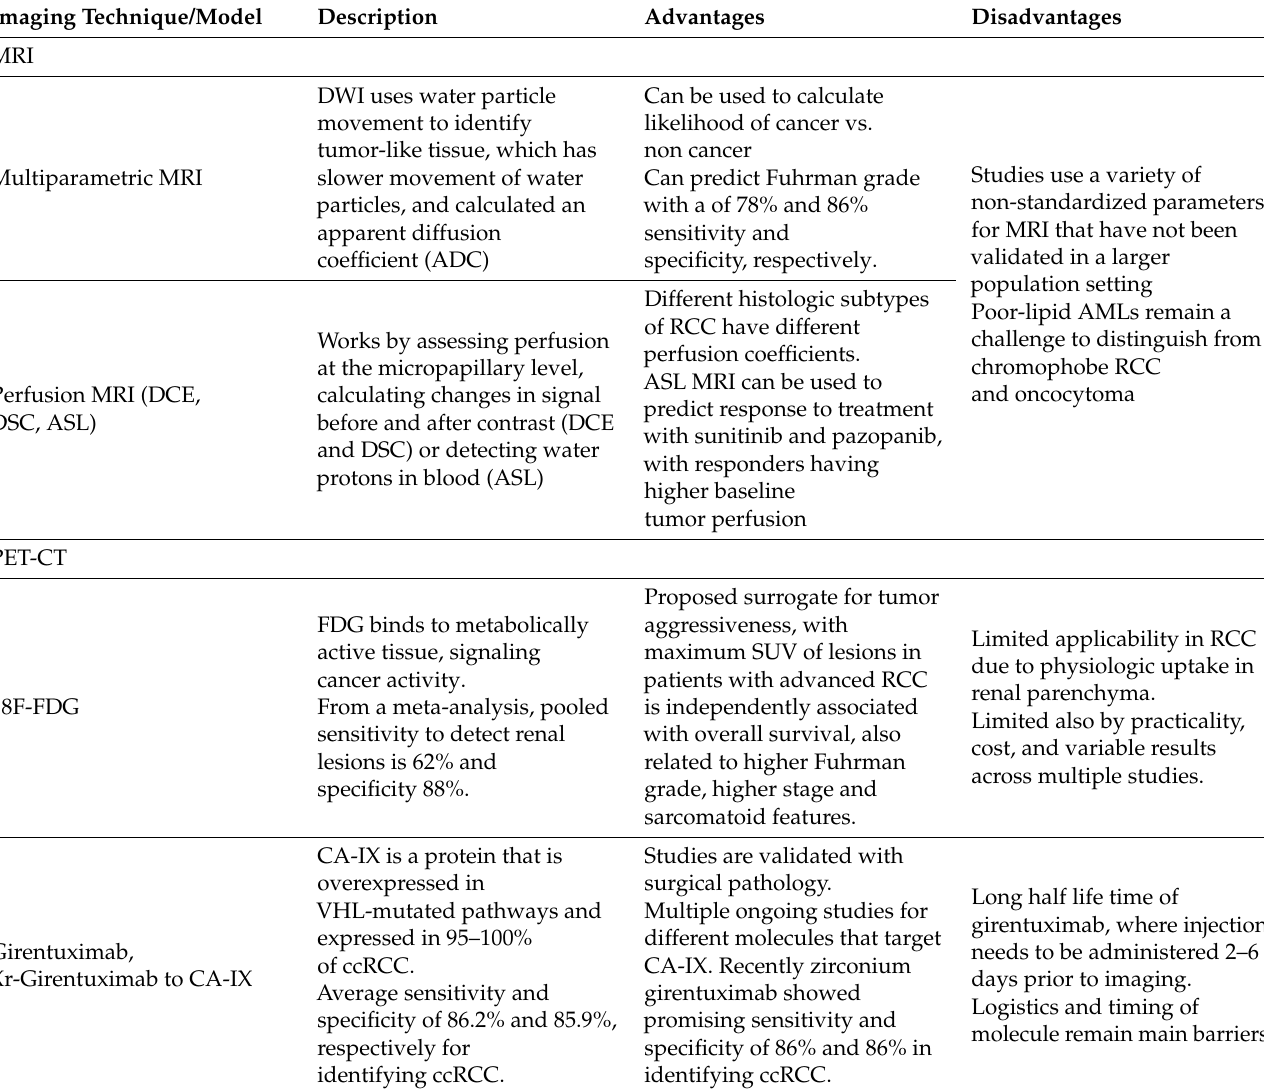
Table 1. Summary of imaging-based